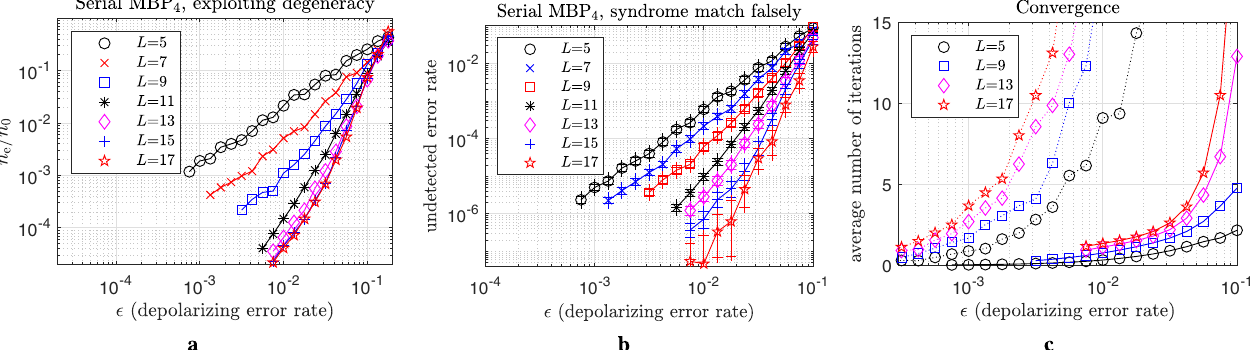
Fig. 6 Some statistical results of serial MBP 4 ( α = 0.65) on surface codes (solid lines). a The error suppression ratio n e / n 0 . b Undetected error rate. c Average numbers of iterations (solid lines); also shown in c are the numbers for the conventional BP 4 (dotted lines). In b , an error bar between two crosses indicates the 95% con fi dence interval. Table 2. The error thresholds and computation complexities of